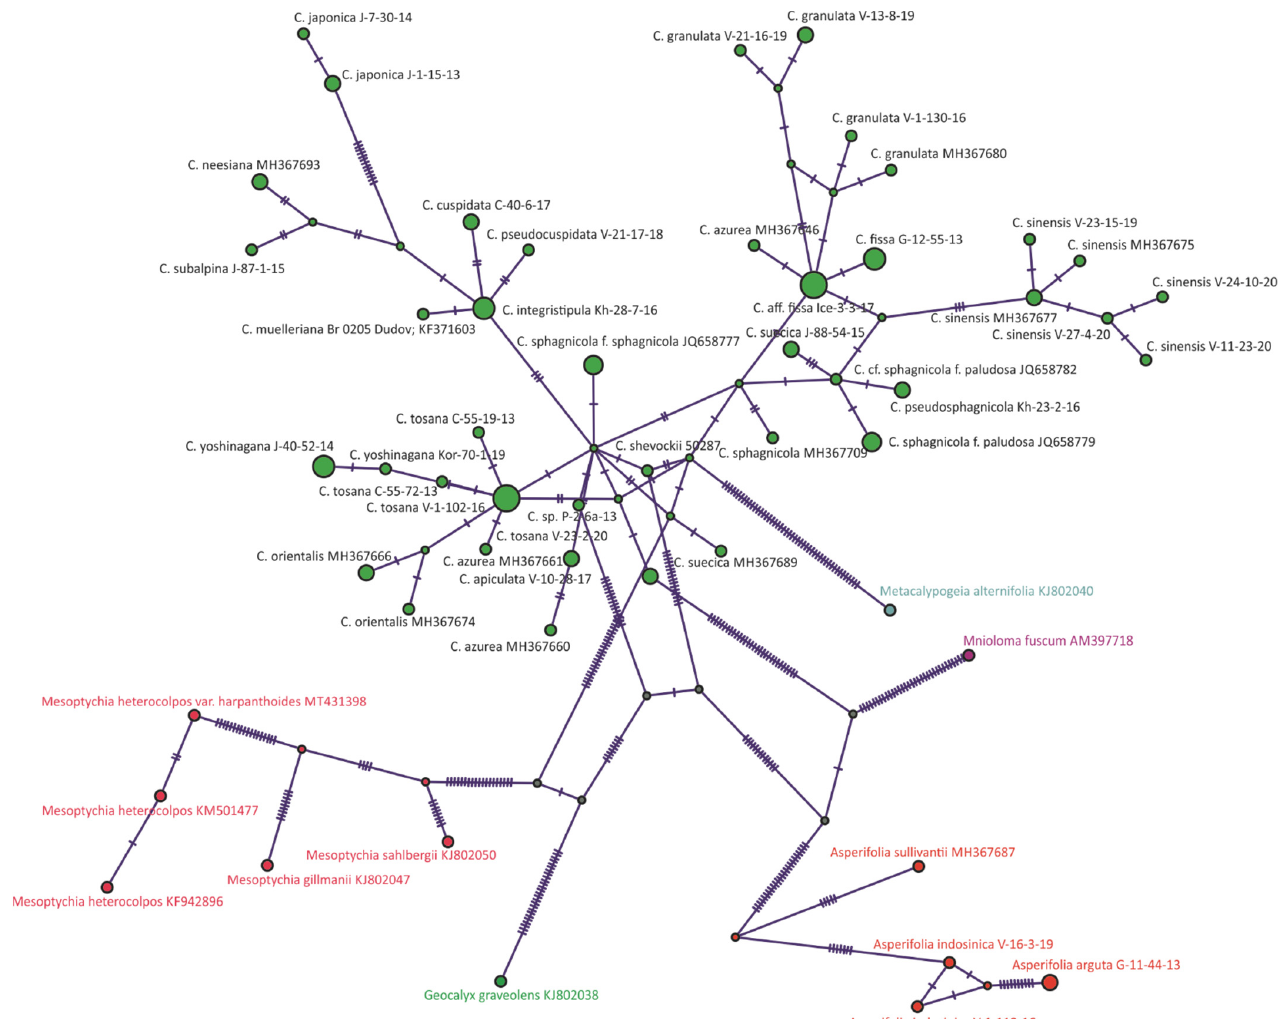
Figure 2. TCS haplotype network of trn G sequences.